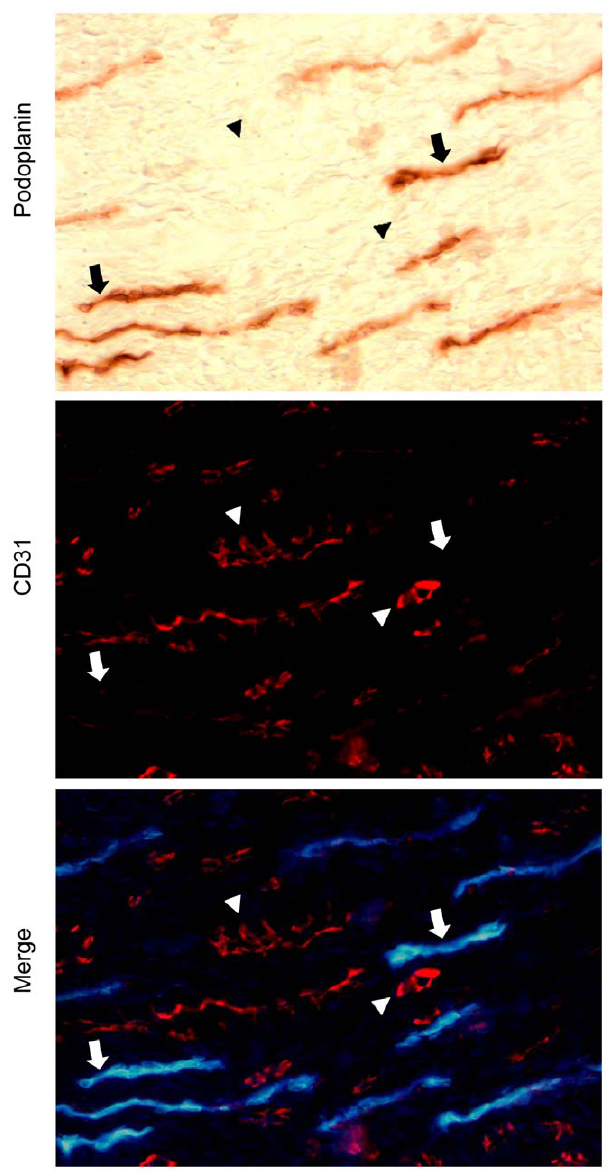
Figure 2. Double labeling of lymphatic and CD31-positive vessels in RA synovial tissues. Lymphatic vessels were detected by immunoperoxidase (brown immunostaining) detection of podoplanin and double immunofluorescent labeling (red fluorescence) of CD31. The same field was photographed by light or fluorescent microscopy to show the position of CD31 + (arrowheads) and podoplanin + vessels (arrows). Light microscopy image was inverted and merged with CD31 fluorescent image of the same field to show the relative position of podoplanin (blue) and CD31 (red) labeling.